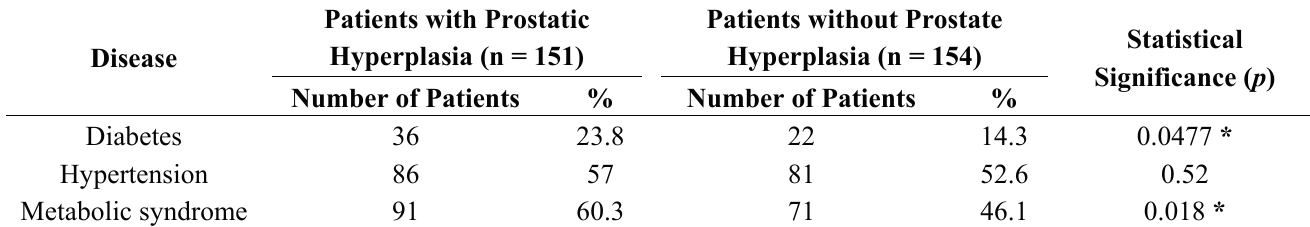
Table 1. Metabolic diseases in patients with and without benign prostatic hyperplasia.